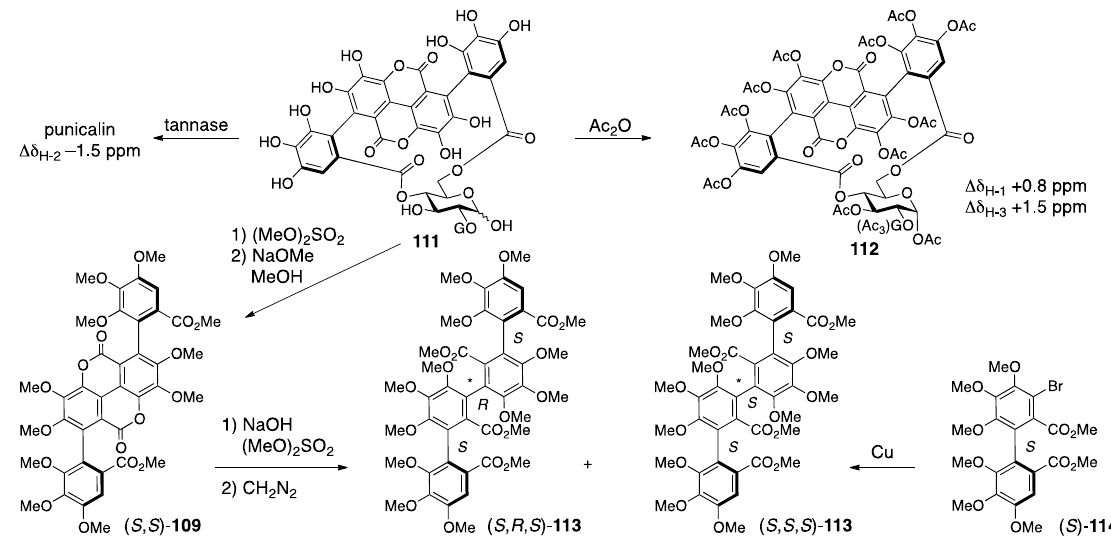
Figure 42. The transformations that led to the latest structures of punicalin and punicalagin.